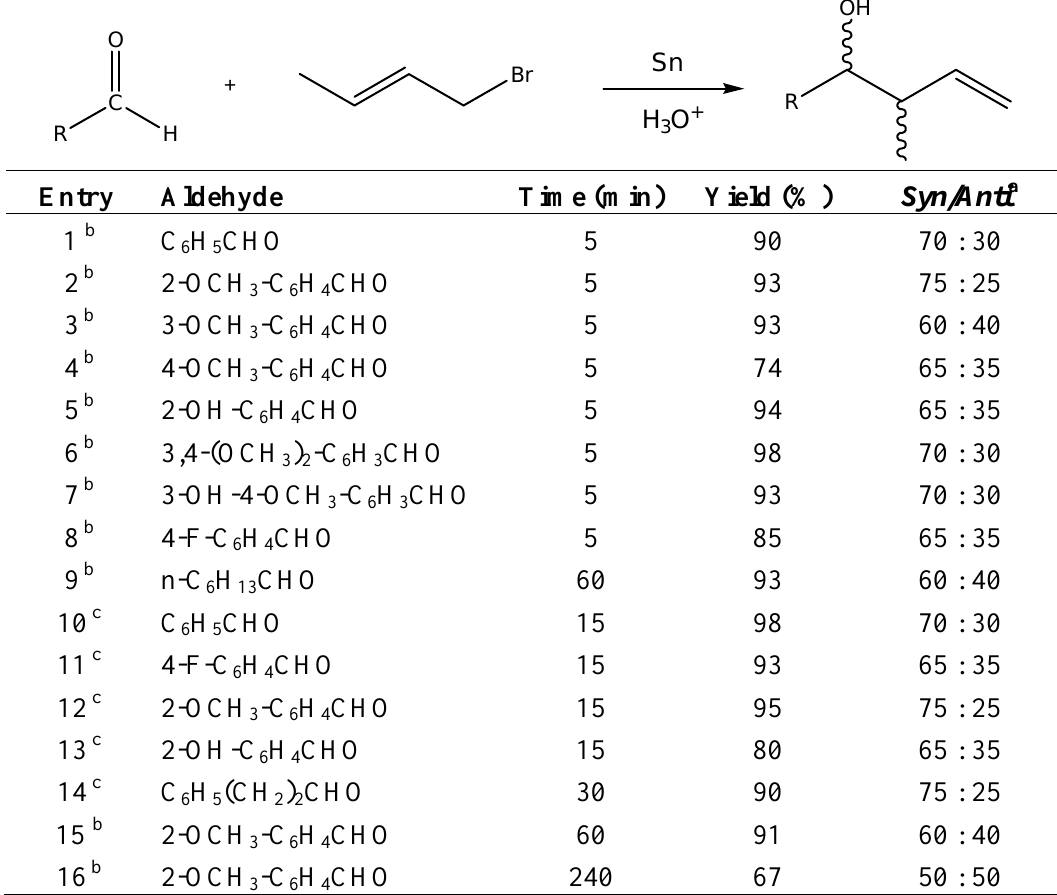
Table 3. Allylation of aromatic and aliphatic aldehydes with crotyl bromide mediated by tin in HCl solution at room